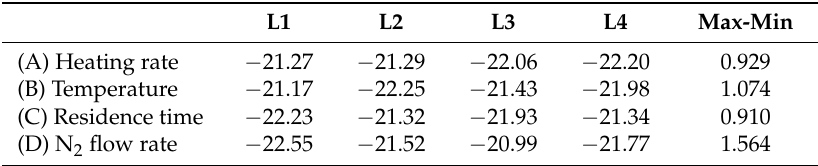
Table 5. S / N response table for sludge pyrolytic oil.